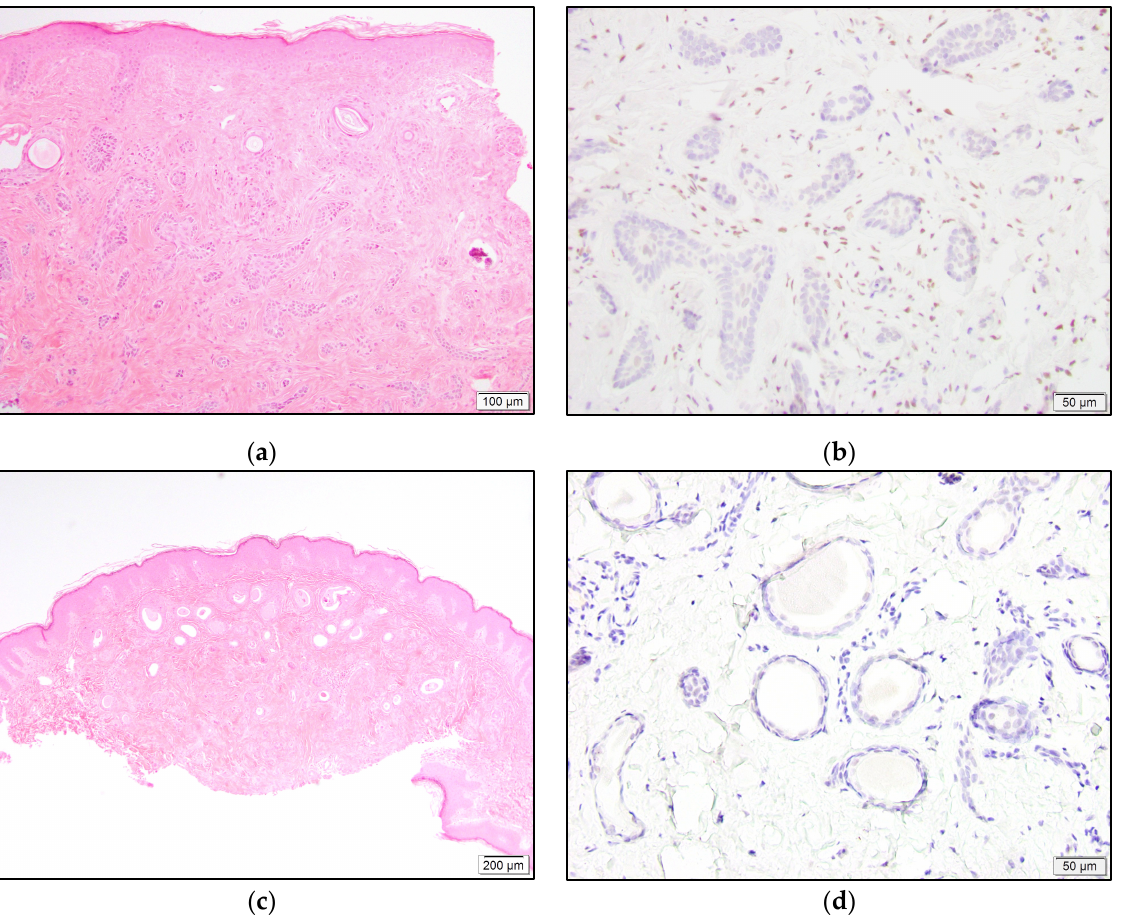
Figure 6. Infiltrative growth pattern of MAC with cords of small cuboidal cells and occasional duct formation ( a ). Negative TRPS1 staining in malignant cells and dermal mesenchymal cells, with positive staining ( b ). Well-circumscribed syringoma with tadpole-shaped ducts ( c ). Lack of TRPS1 expression in neoplastic cells ( d ).